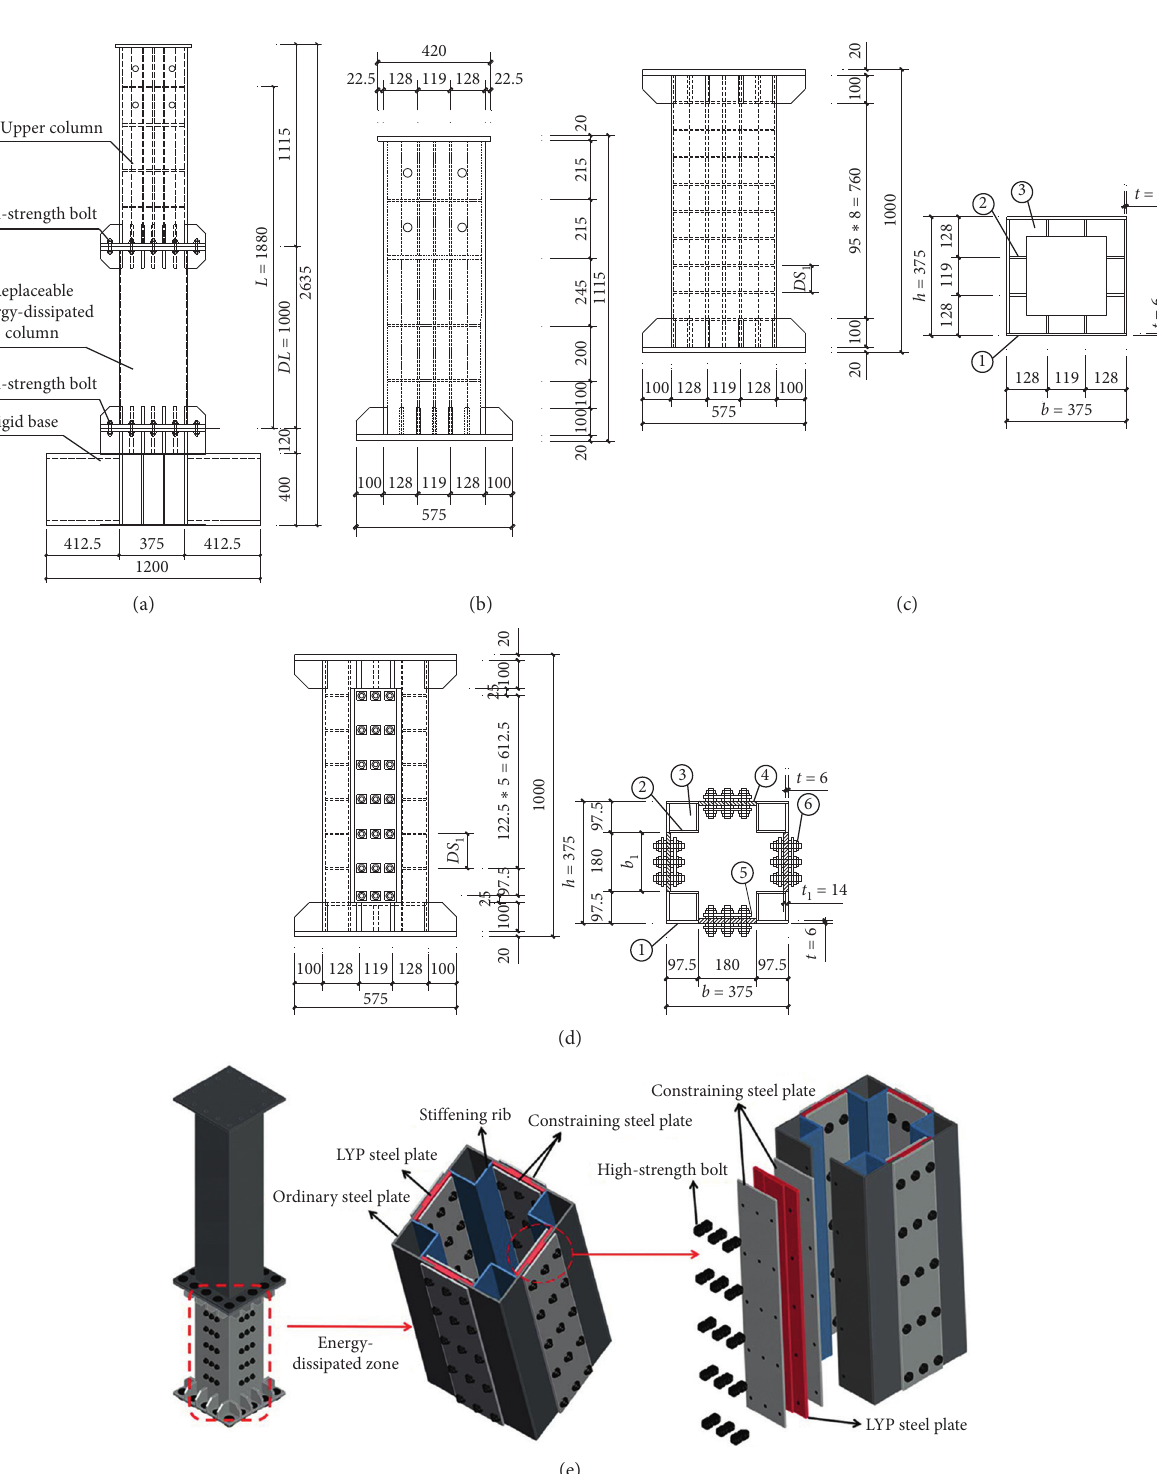
Figure 1: Design drawing of pseudostatic specimens. (a) Front elevation of specimens. (b) Front elevation of upper column. (c) Energy- dissipated column of specimens in group I. (d) Energy-dissipated column of specimens in group II and group III. (e) Model of energy- dissipated zone in group II and group